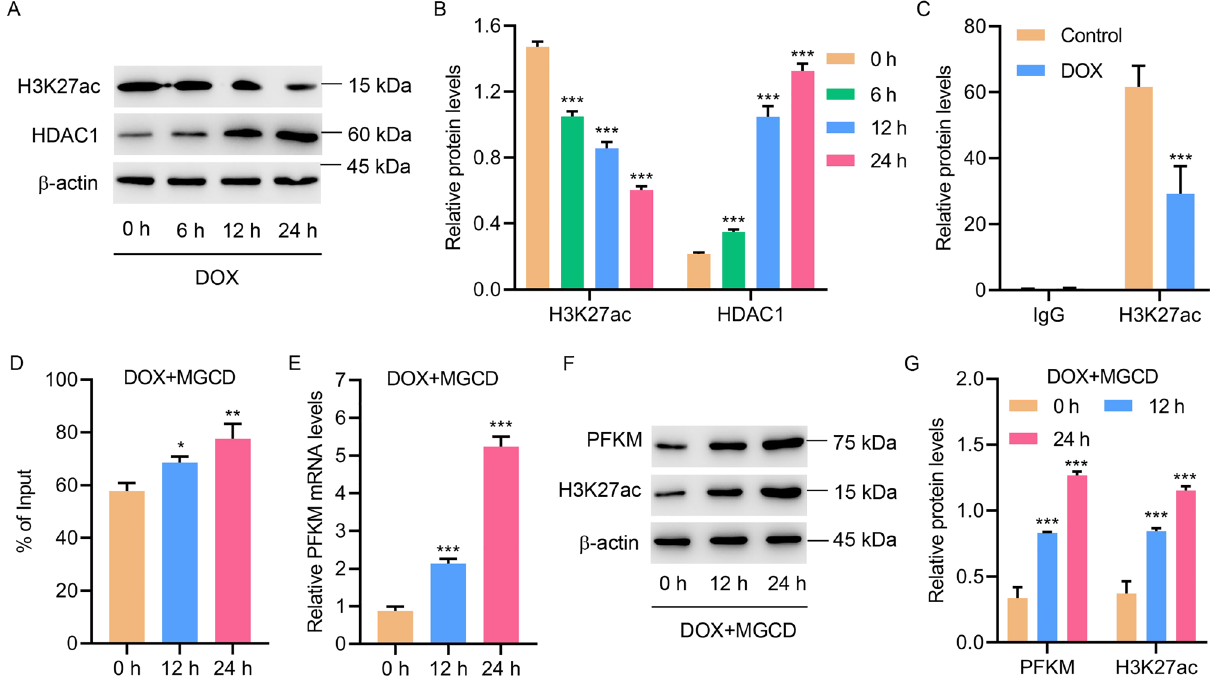
Figure 5. HDAC1 inhibited H3K27ac-induced transcription of PFKM in DOX-induced H9c2 cells. ( A , B ) H3K27ac and HDAC1 levels in DOX-treated H9c2 cells. ( C ) ChIP assay of H3K27ac on the PFKM promoter in DOX-treated H9c2 cells. ( D ) ChIP assay of H3K27ac on the PFKM promoter and ( E – G ) expression of PFKM and H3K27ac in H9c2 cells treated with 2 μM DOX and 0.1 μM MGCD for different time points. *P < 0.05, **P < 0.01, ***P < 0.001 vs 0 h or control. (see Supplementary Fig.